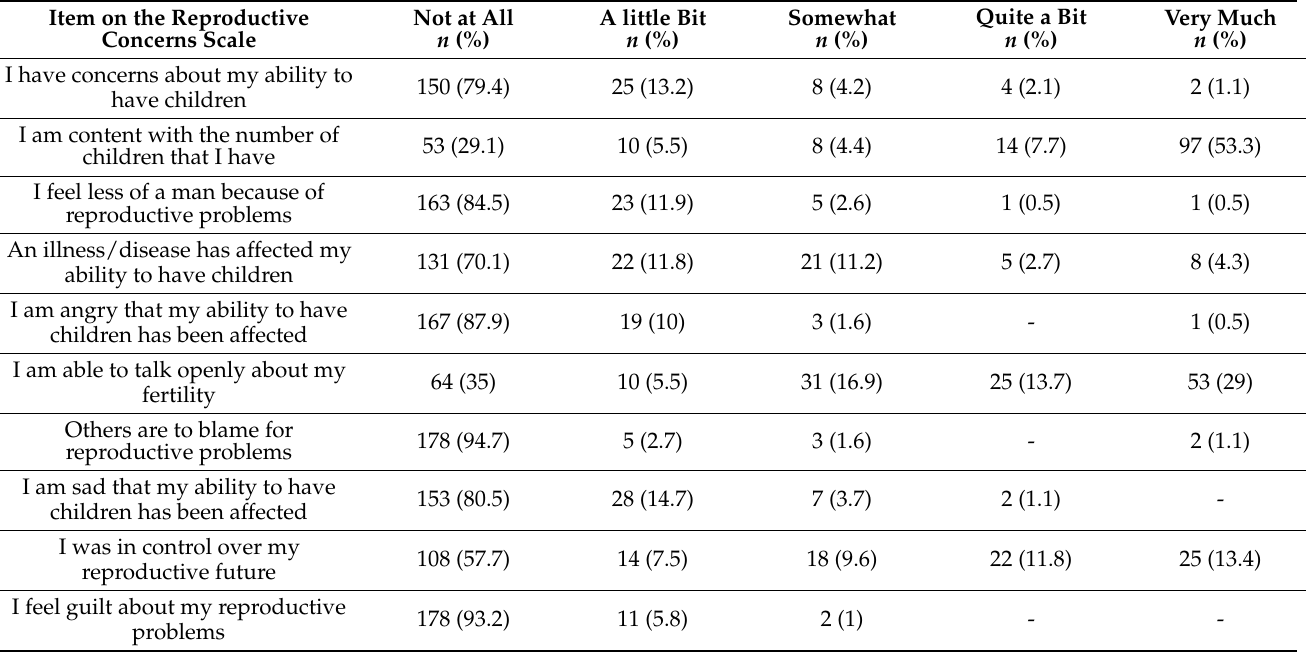
Table 6. Results of the Reproductive Concern Scale adjusted for